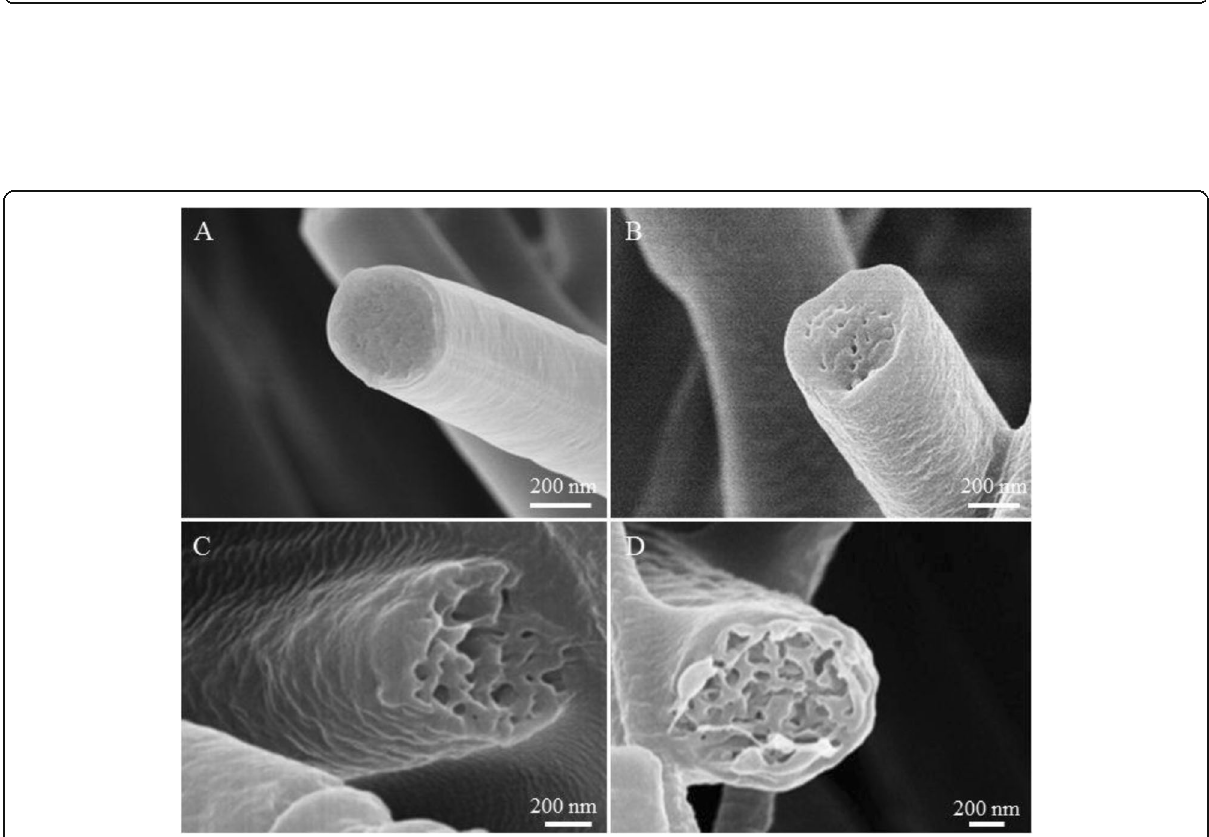
Fig. 4 Representative SEM images of samples fabricated by electrospinning 35% ( w / v ) PVDF solution from DMF at different levels of relative humidity. a 5%, b 25%, c 45%, and d 65%